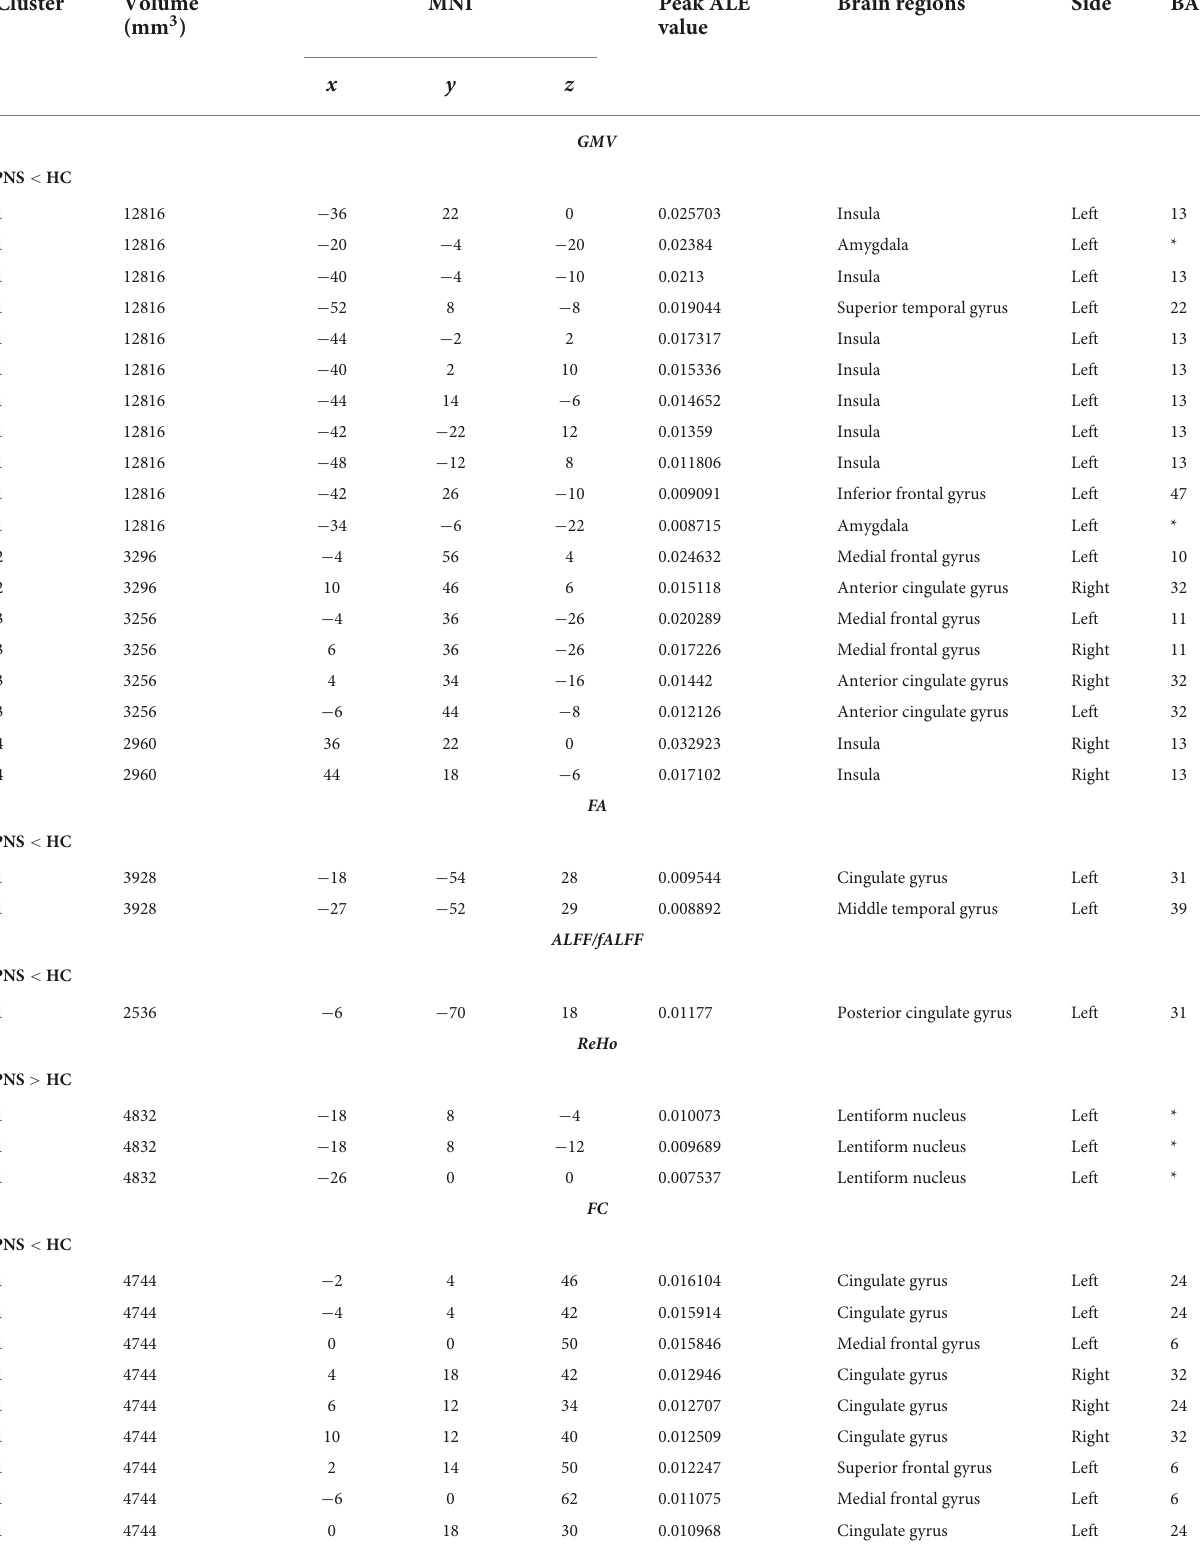
TABLE 3 Brain structural and functional abnormalities in schizophrenia with